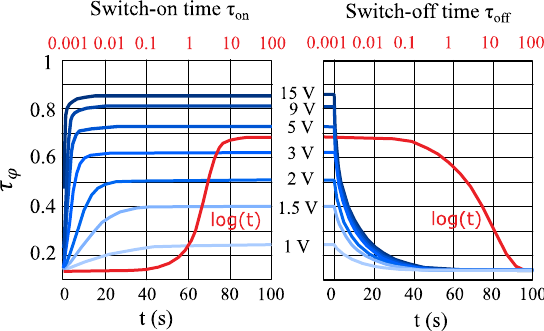
Figure 17. Orientation effectivity 𝜏 (cid:3101) versus time for 𝜏 (cid:2925)(cid:2924) and 𝜏 (cid:2925)(cid:2916)(cid:2916) for the cross-sectional pre- orientation of an IMSL of h LC =100 µm filled with GT3. The parameter is the biasing voltage 𝑉 (cid:3029) from 1 to 15 V. In addition, there are logarithmically scaled curves for 𝑉 (cid:3029) = 4 V [74]. Reprinted from [2], In addition, there are logarithmically scaled curves for V b = 4 V [74]. Reprinted from [2], Cambridge University Press, 2020.